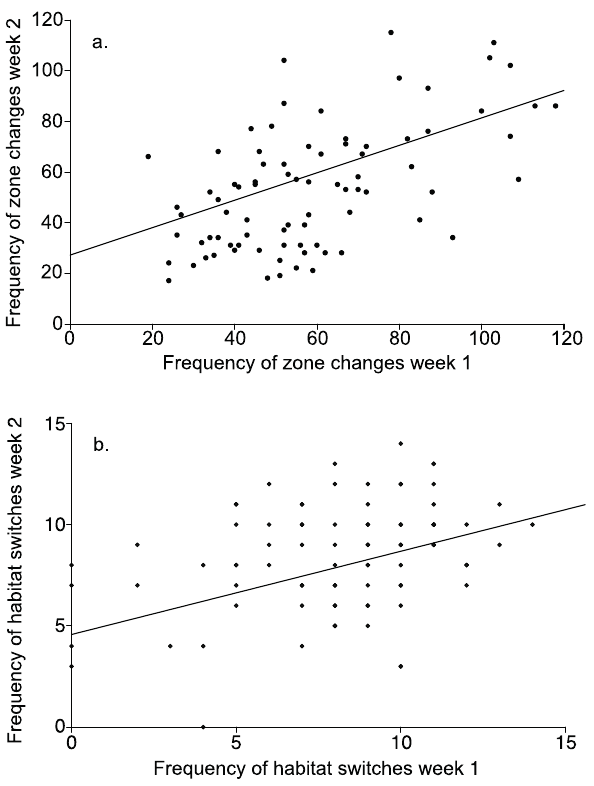
Figure 2. Individual consistency in (a) activity levels and (b) exploration in